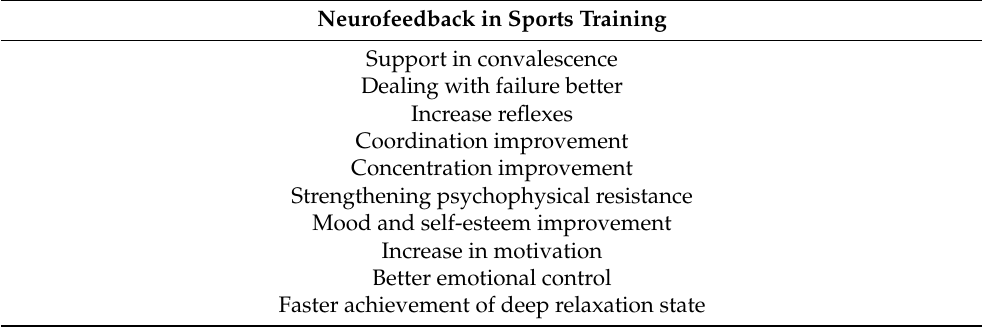
Table 5. EEG neurofeedback advantages in relation to sports